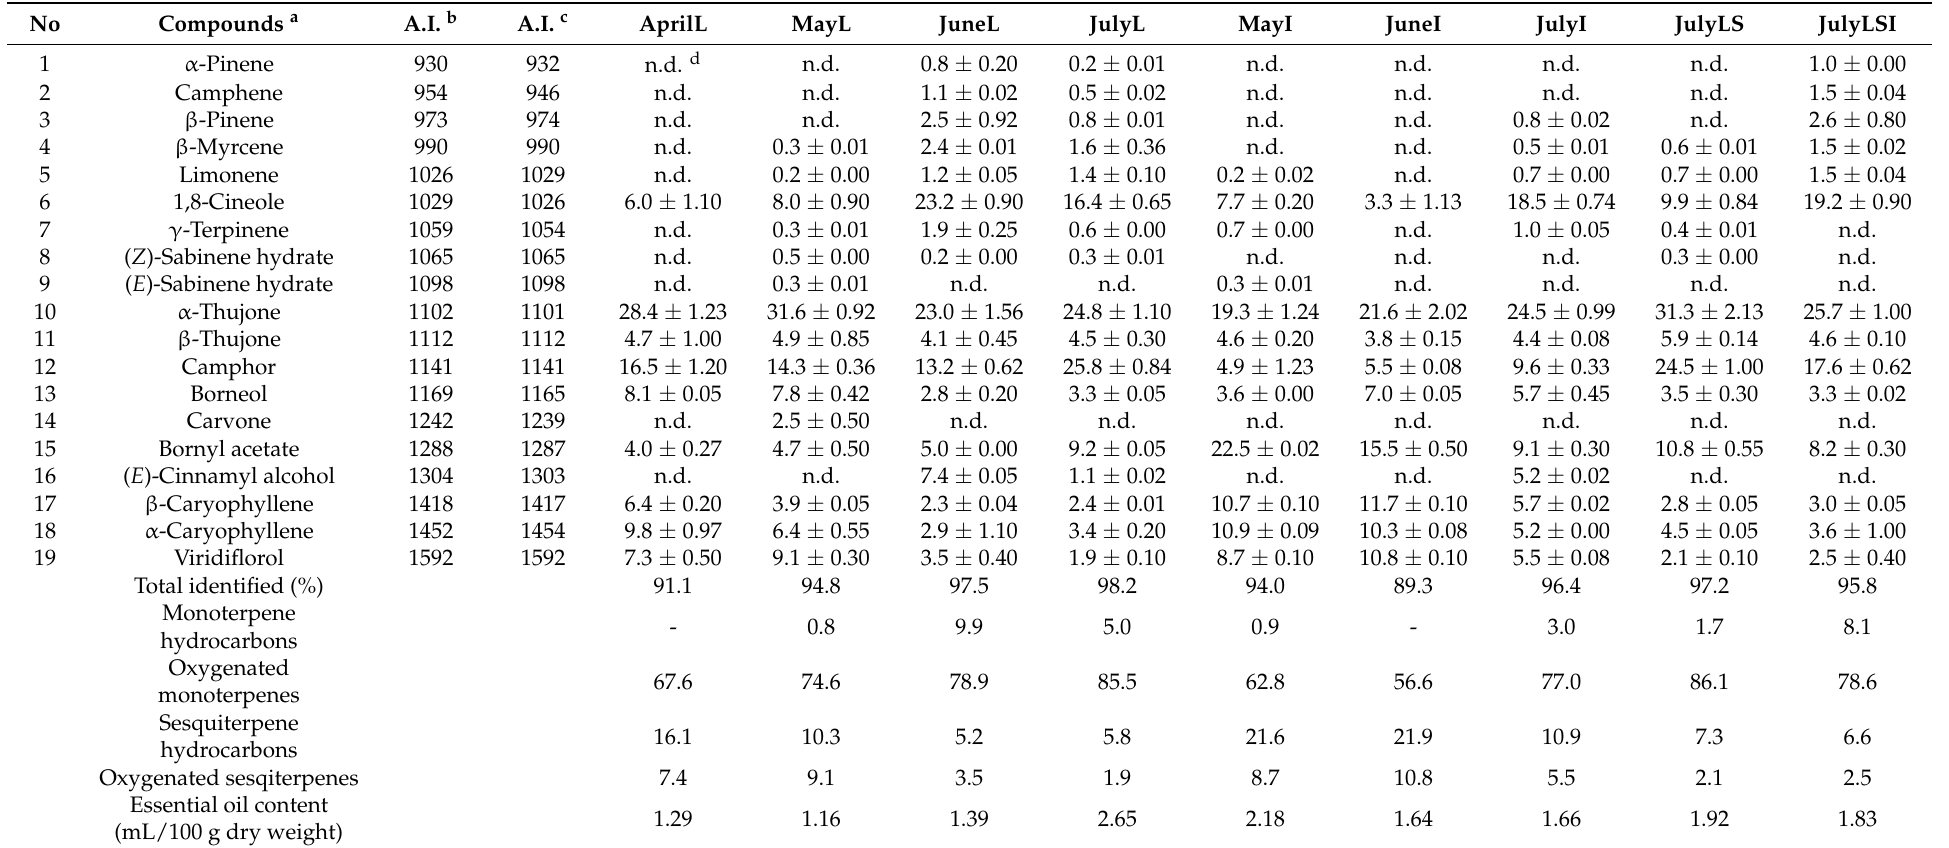
Table 4. Qualitative and quantitative composition of the Essential oils parts from S. officinalis